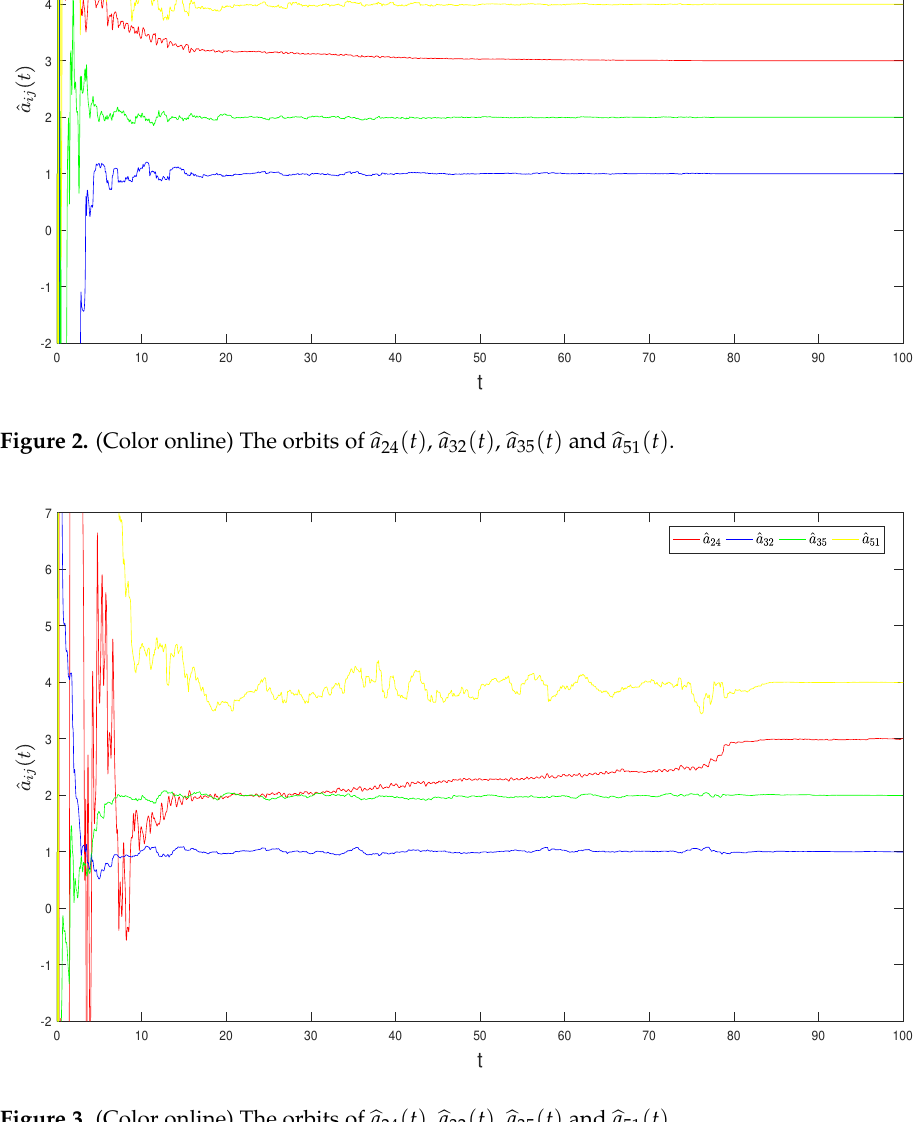
Figure 3. (Color online) The orbits of (cid:98) a 24 ( t ) , (cid:98) a 32 ( t ) , (cid:98) a 35 ( t ) and (cid:98) a 51 ( t )